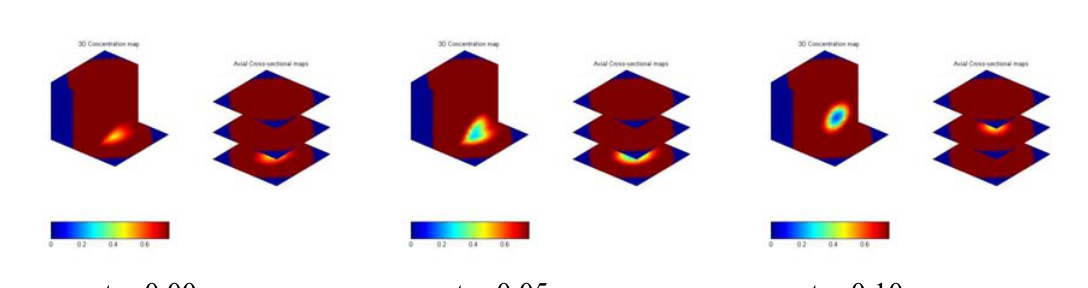
t = 0.00 t = 0.05 t =